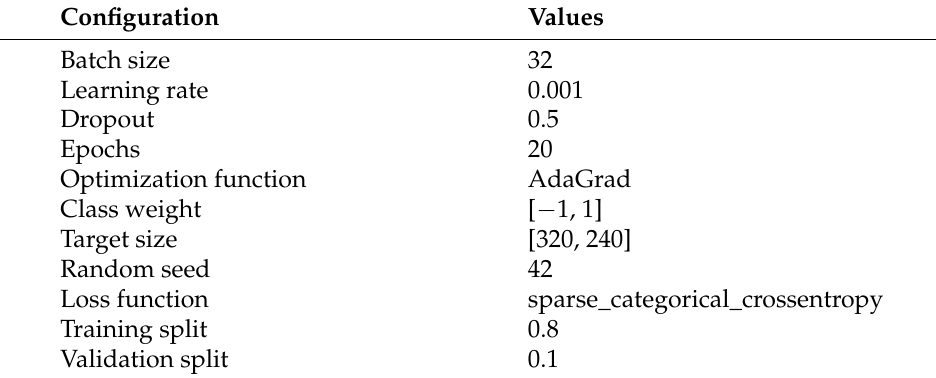
Table 6. Hyperparameter configuration